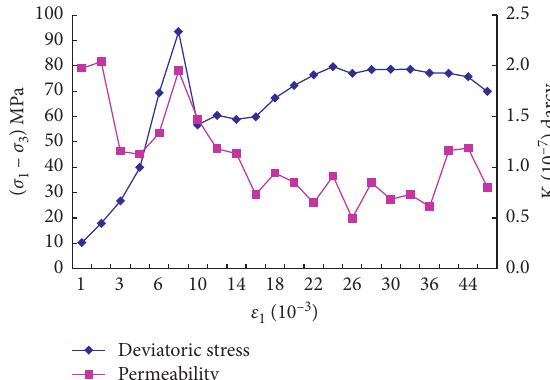
Figure 11: Permeability-principal stress difference curves of B3-1.